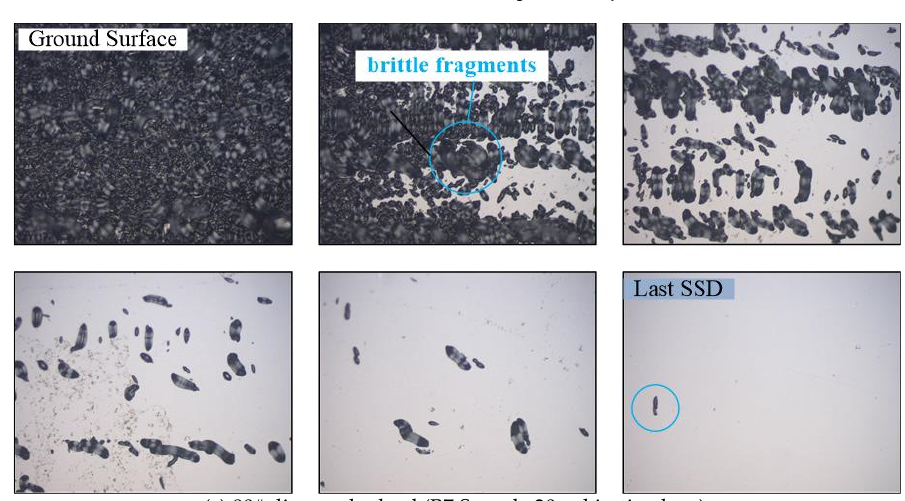
Figure 7. The morphology of subsurface in ground optical samples.